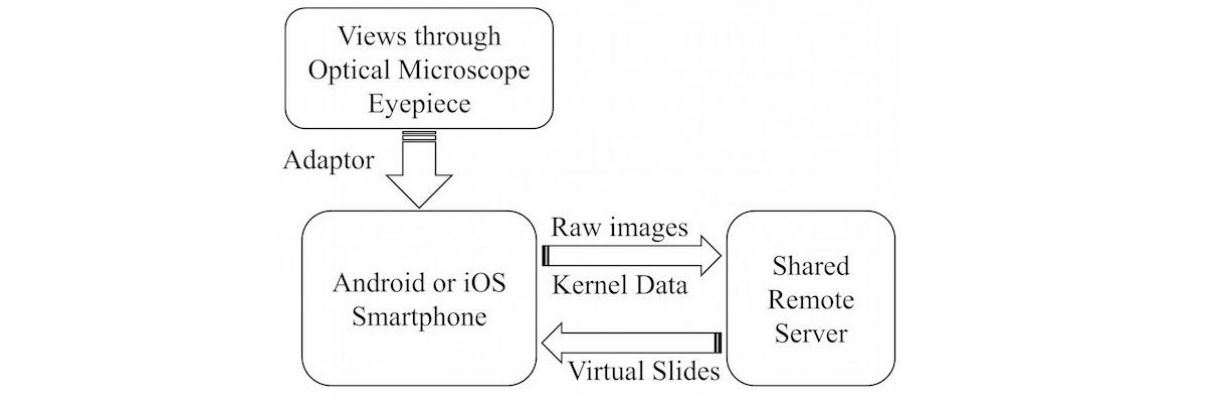
Figure 1. Simplified sWSI solution structure.